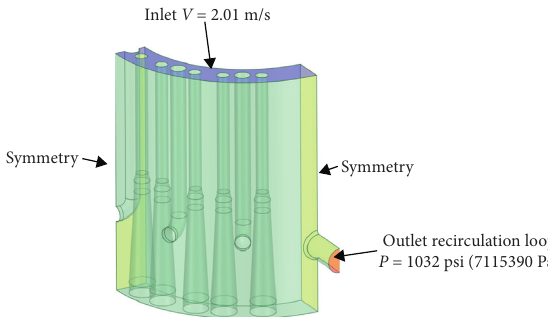
Figure 14: Control volume and boundary conditions considered in the analysis of the zone of